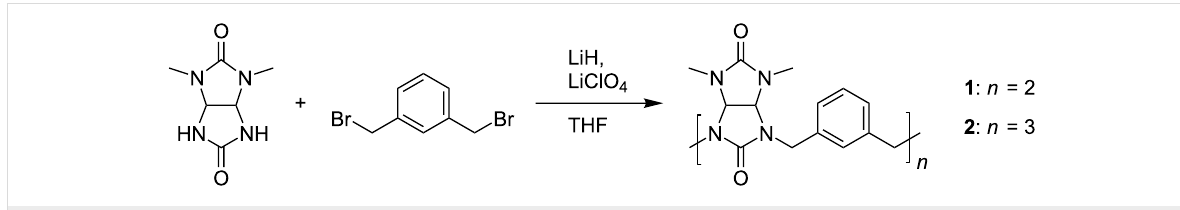
Scheme 1: Reaction of 2,4-dimethylglycoluril and m -xylylene dibromide.